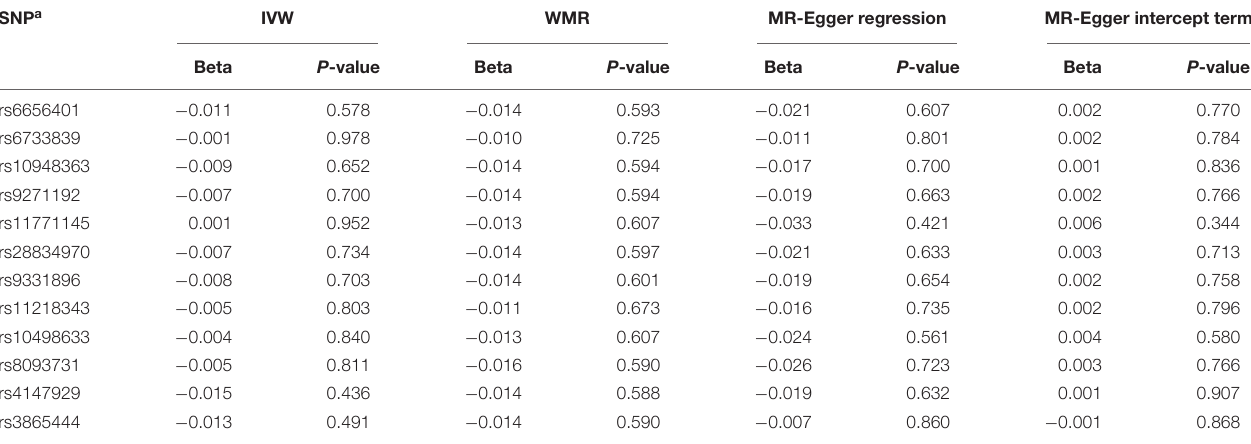
TABLE 7 | The sensitive analysis results of the 12 genetic